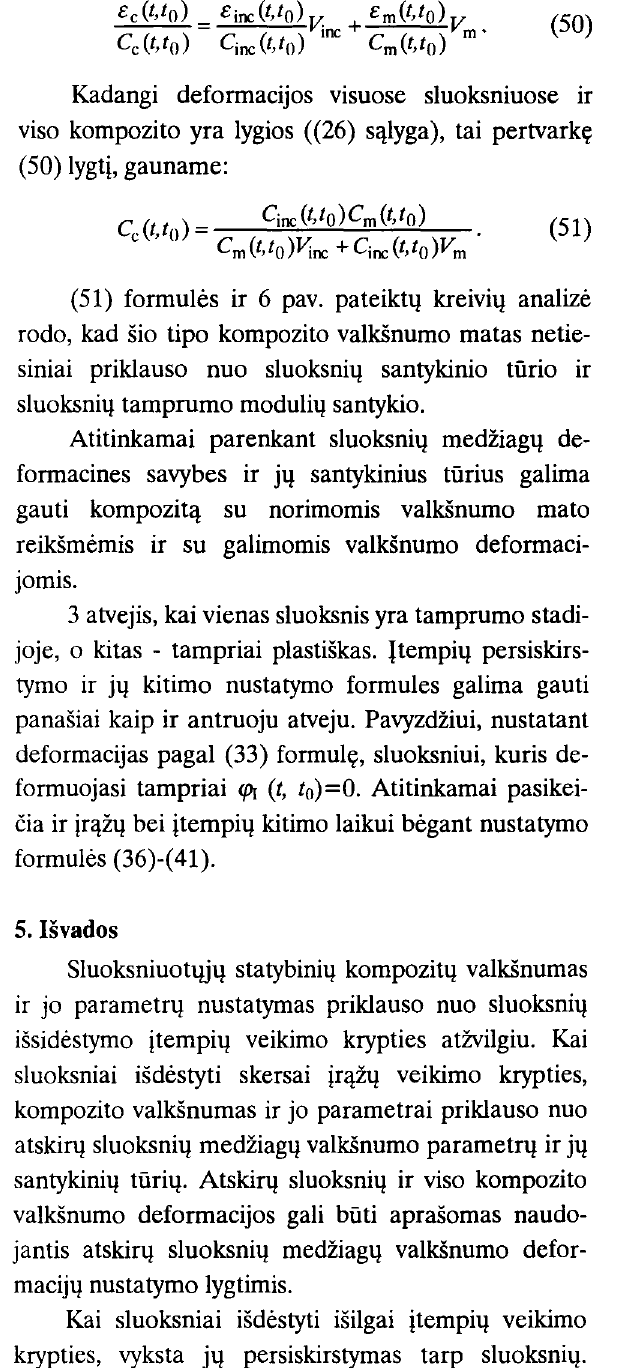
Fig 6. Variation of ratio of creep factors J [ Cc (t, tojcinc (t, to) of composite and that of the weaker layer in relation to the relative volume of this layer and to the ratio of creep factors [Cinc(t,toYcm(t,to)J of layers, values of which are indicated at the